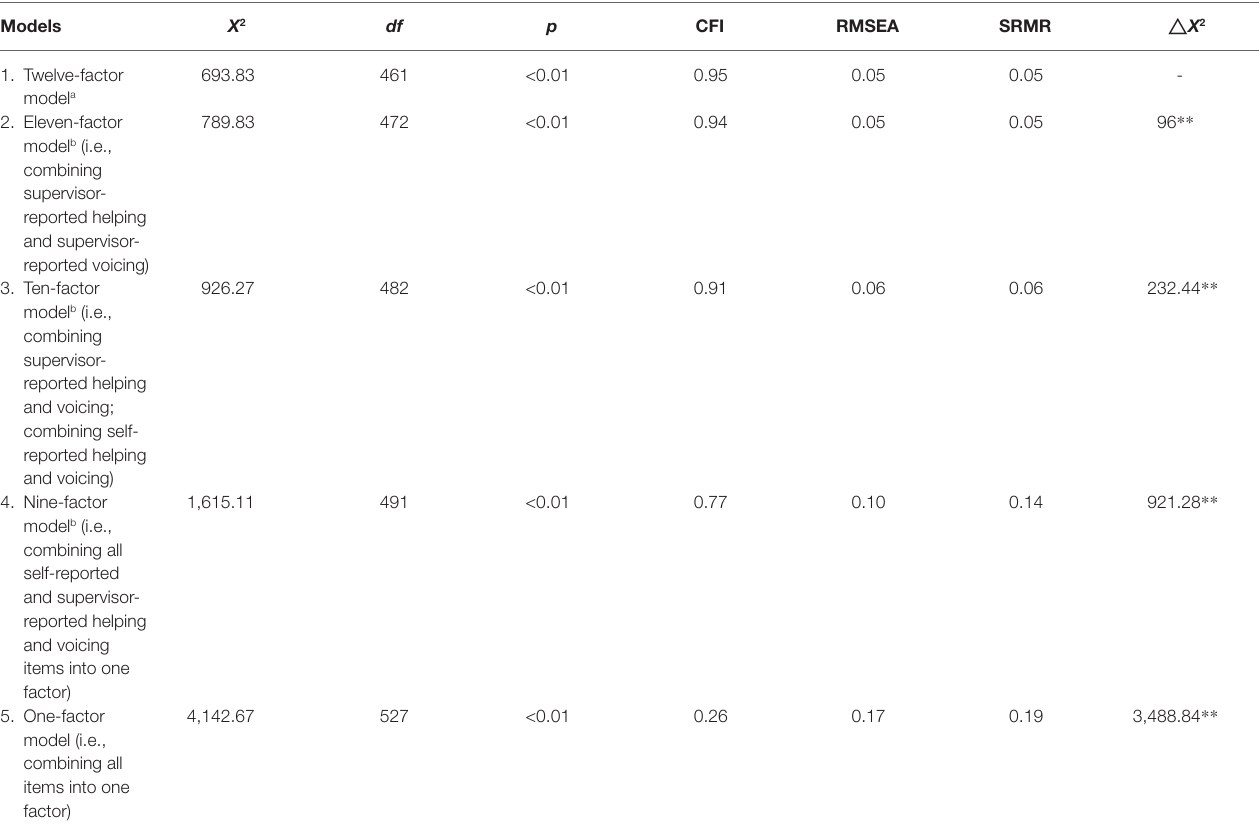
TABLE 2 | Construct validity for the studied